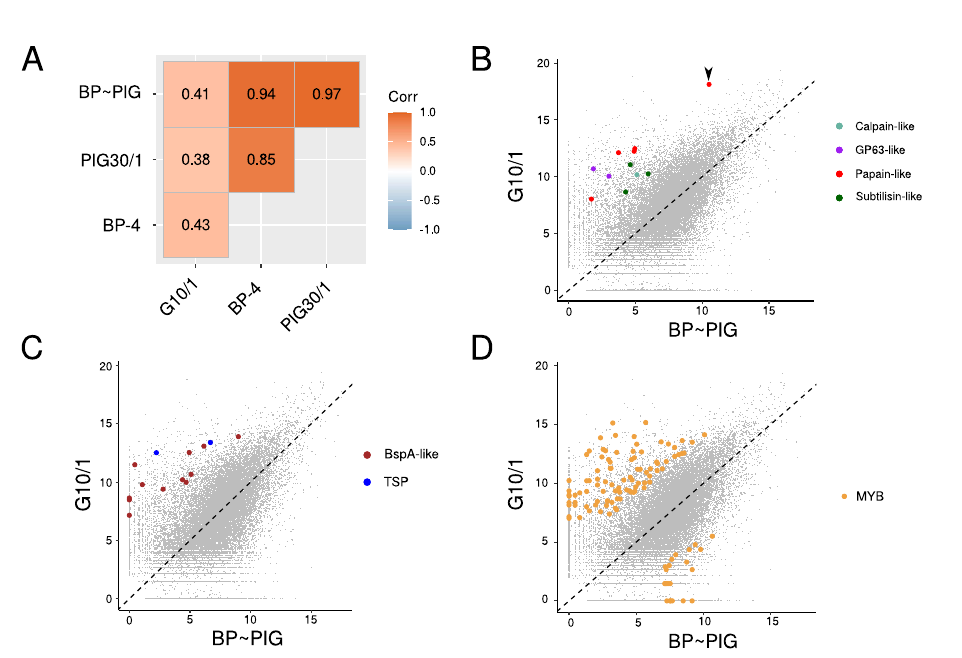
Figure 3. Analysis of predicted pathogenic and adaptive factors in the three isolates. ( A ) A correlation heatmap for the Spearman’s coefficients for abundance values (FPKM) of predicted virulence factors analyzed in this work; Corr = Correlation coefficients code. Values are coded from light blue (− 1) to deep orange (1). Scatter plots for analyzed factors, those mostly abundant (fc > 4) in G10/1 isolate were highlighted ( B ) proteases; black arrow head: TfCP7 ( C ) surface antigens; TSP: tetraspanin proteins ( D ) MYB proteins; more expressed MYB transcripts ( log 2 ( fc ) = 4) on BP ~ PIG are also